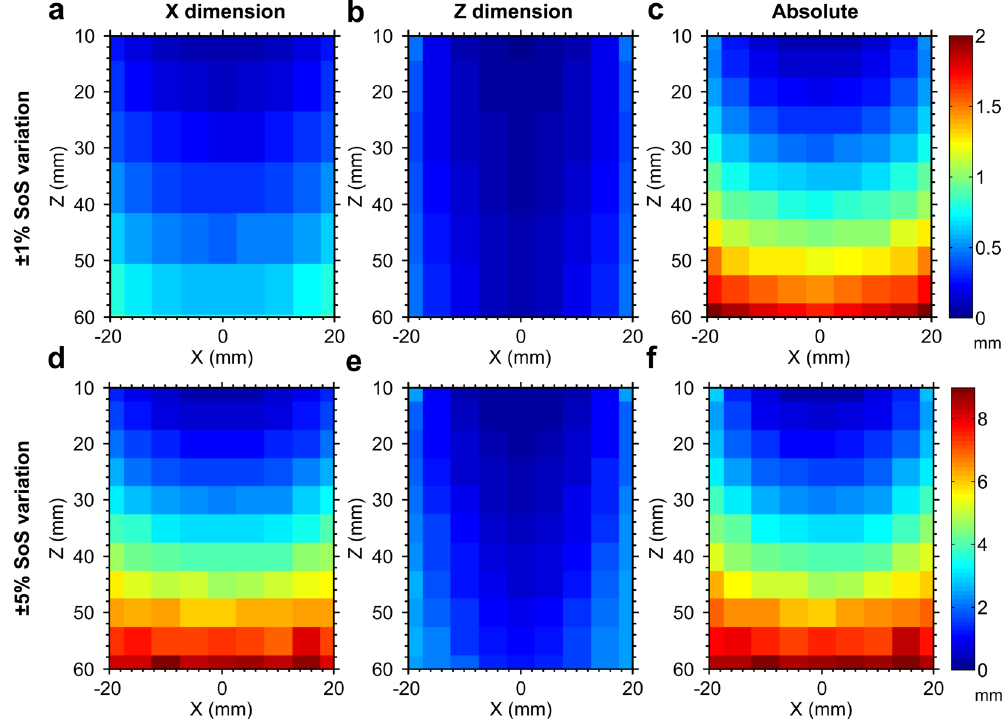
Figure 3. Effects of tissue speed of sound (SoS) heterogeneity on tracking accuracy with Monte Carlo simulation. The SoS in tissue varied randomly with a variation of 1% ( a–c ) or 5% ( d–f ) in these simulations, whilst the assumed SoS used for obtaining tracking estimates was held constant at 1540 m/s. Tracking accuracy in the Z (depth) dimension ( b , e ) was better than that in the X (out-of-plane) dimension ( a , d ). The absolute tracking accuracy ( c , f ) tended to improve with decreasing depth and with decreasing out-of-plane